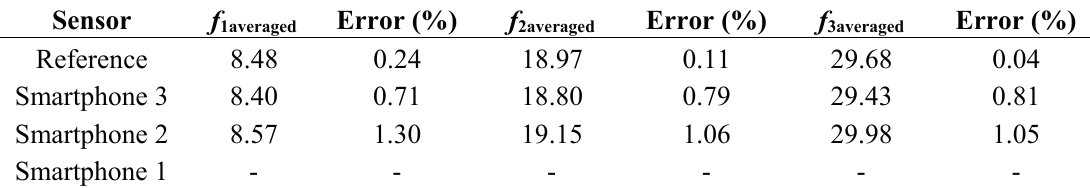
Figure 10. Arias intensities obtained from different samples. Table 3. Identified modal